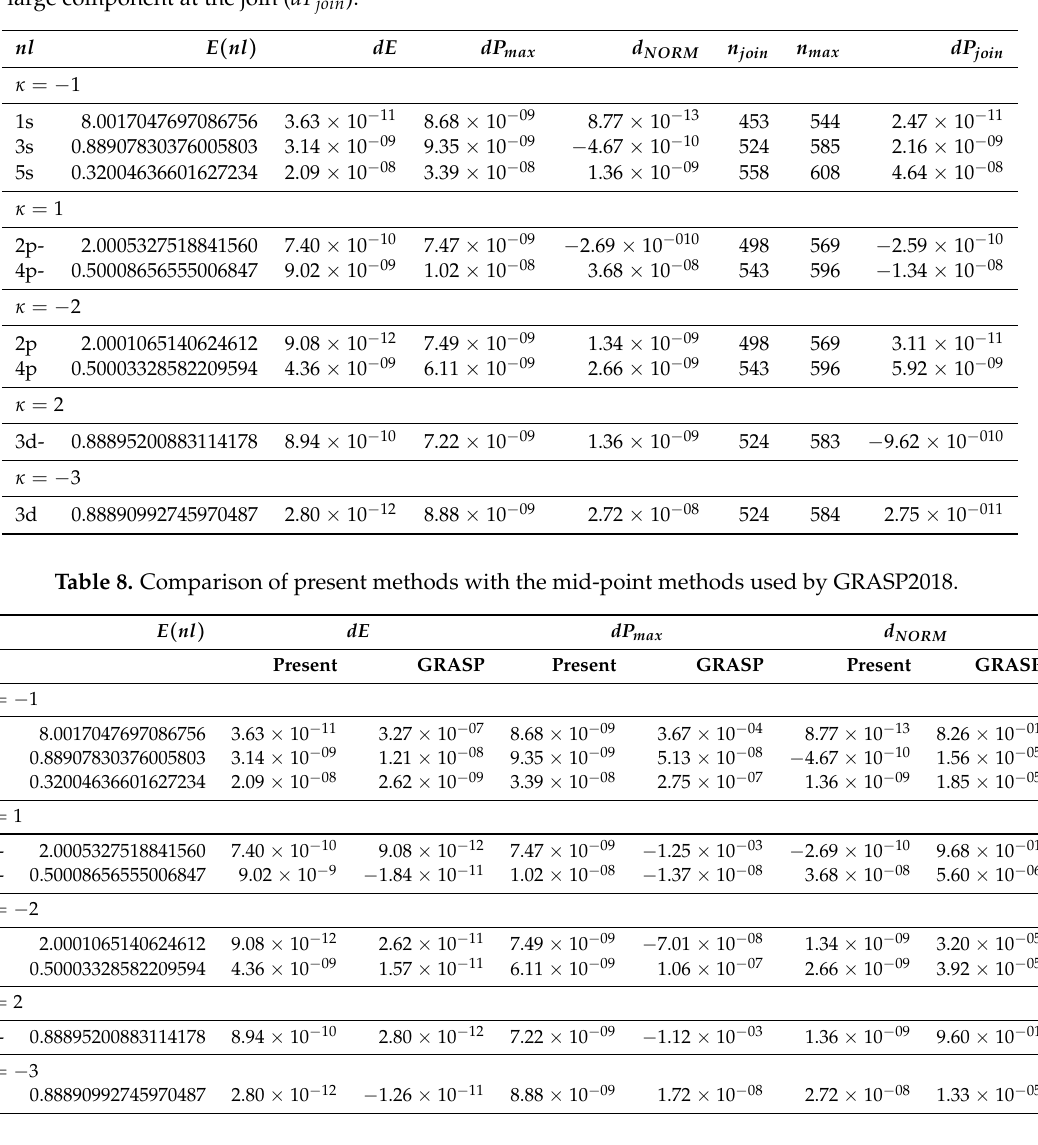
Table 7. Results showing the accuracy of the one-electron equation for Z = 4 from the results based on Simpson’s rule. Shown are the absolute errors in the orbital energy computed from the ”exact” wave functions ( dE ), the maximum change in the computed radial function ( dP max ) before normalization, the error in the normalization integral ( d NORM ) for the solution of the differential equations, the location of the join ( n join ) of outward and inward integration, the range of the solution ( n max ) and difference in the large component at the join ( dP join ).